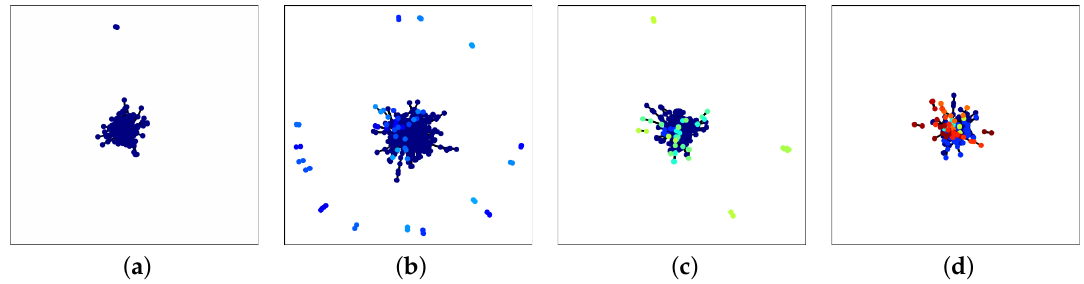
Figure 8. The simplicial complexes K 1 , K 7 , K 13 and K 20 corresponding to the temporal network described in Section 4.2 are visualised in ( a )–( d ), respectively. The number of 0-simplexes in each of these simplicial complexes is 235, 402, 241 and 159, respectively. The number of connected components in each of these simplicial complexes is 4, 28, 17 and 21,